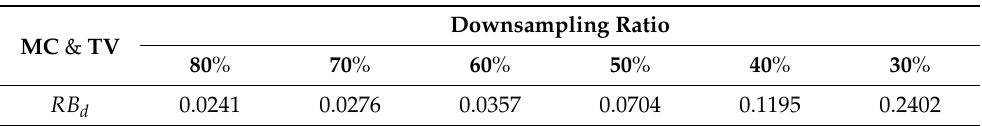
Table 4. The relative bias of the simulated distributed target under different downsampling ratios for the proposed